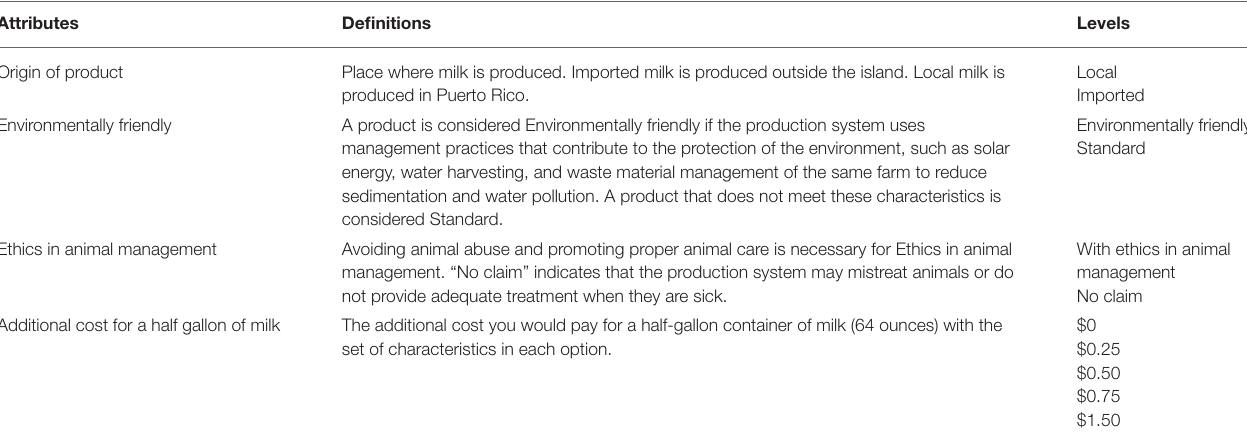
TABLE 1 | Attributes, definitions, and levels used in the choice